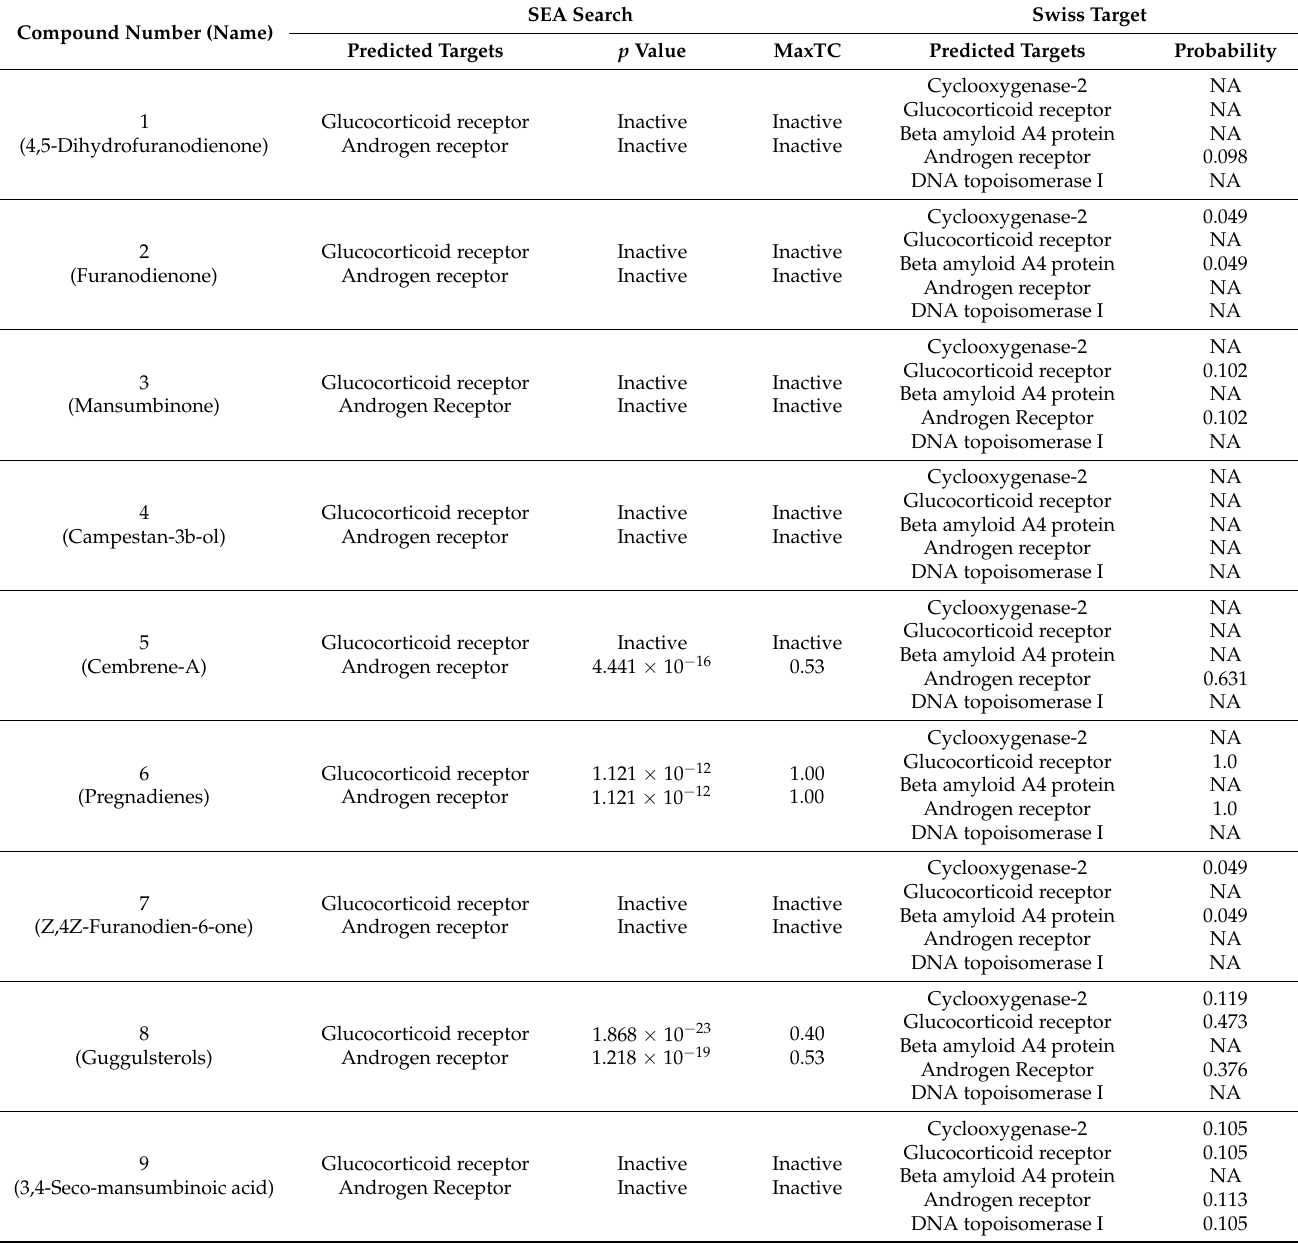
Table 5. Target prediction of crude myrrh resin using Swiss Target and SEA